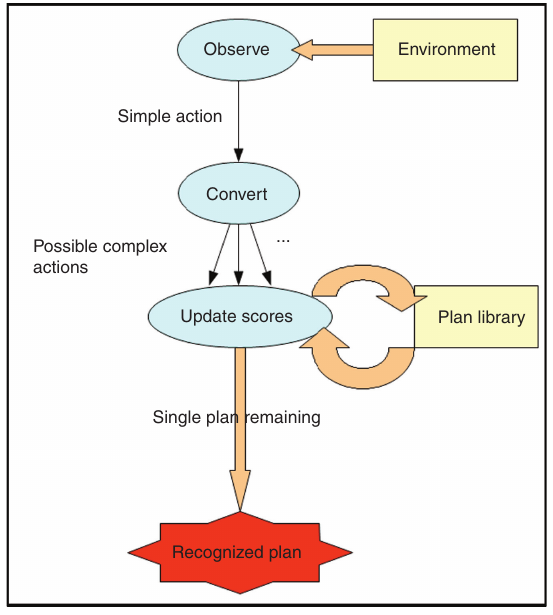
Figure 1. Recognition Structure